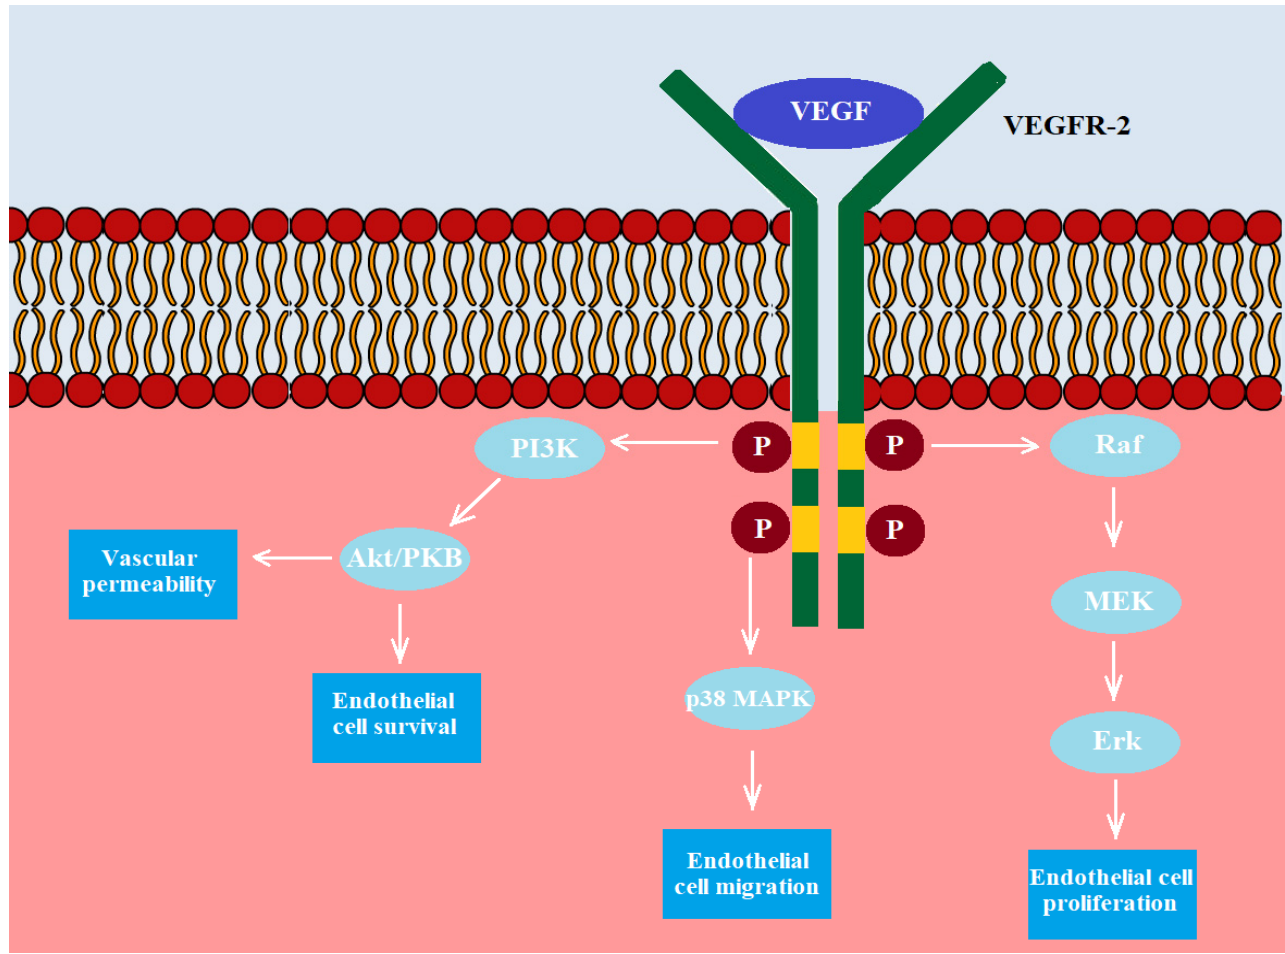
Figure 3. The VEGF receptor (VEGFR) consists of seven domains. VEGF binds to the VEGFR-2 receptor, and then domains within the receptor and below the endothelial membrane are phosphorylated. Next, the phosphorylated domains activate RAF, which then activates MEK1/2, which, in turn, activates ERK1/2. Activated ERK1 or ERK2 either phosphorylates its target cytoplasmic proteins or translocates to the nucleus, where the main targets are transcription factors that regulate proliferation-, differentiation- or survival-related genes. Moreover, the activated VEGFR-2 can activate p38 MAPK and lead to the induction of endothelial cells’ migration. The last pathway associated with VEGFR-R leads to activation of PI3K and then Akt/PKB. Finally, the activation of this pathway leads to increased survival of ECs and vascular permeability.